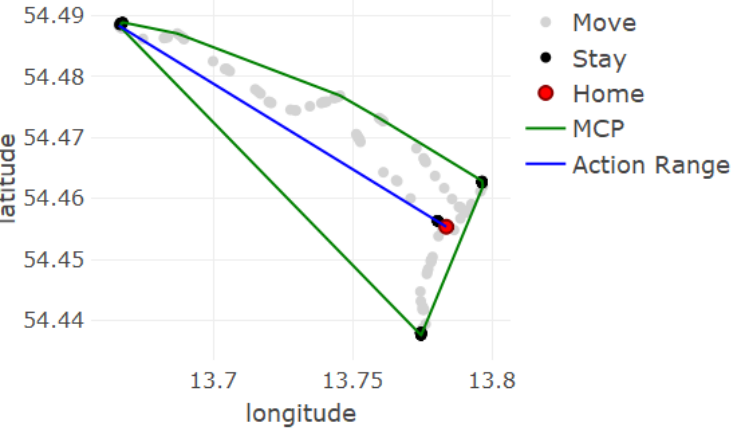
Figure 3. Visual representation of the mobility metrics minimum convex polygon (MCP) and action range, overlaid over global positioning system (GPS) data for one subject for a single day (same trajectory as in Figure